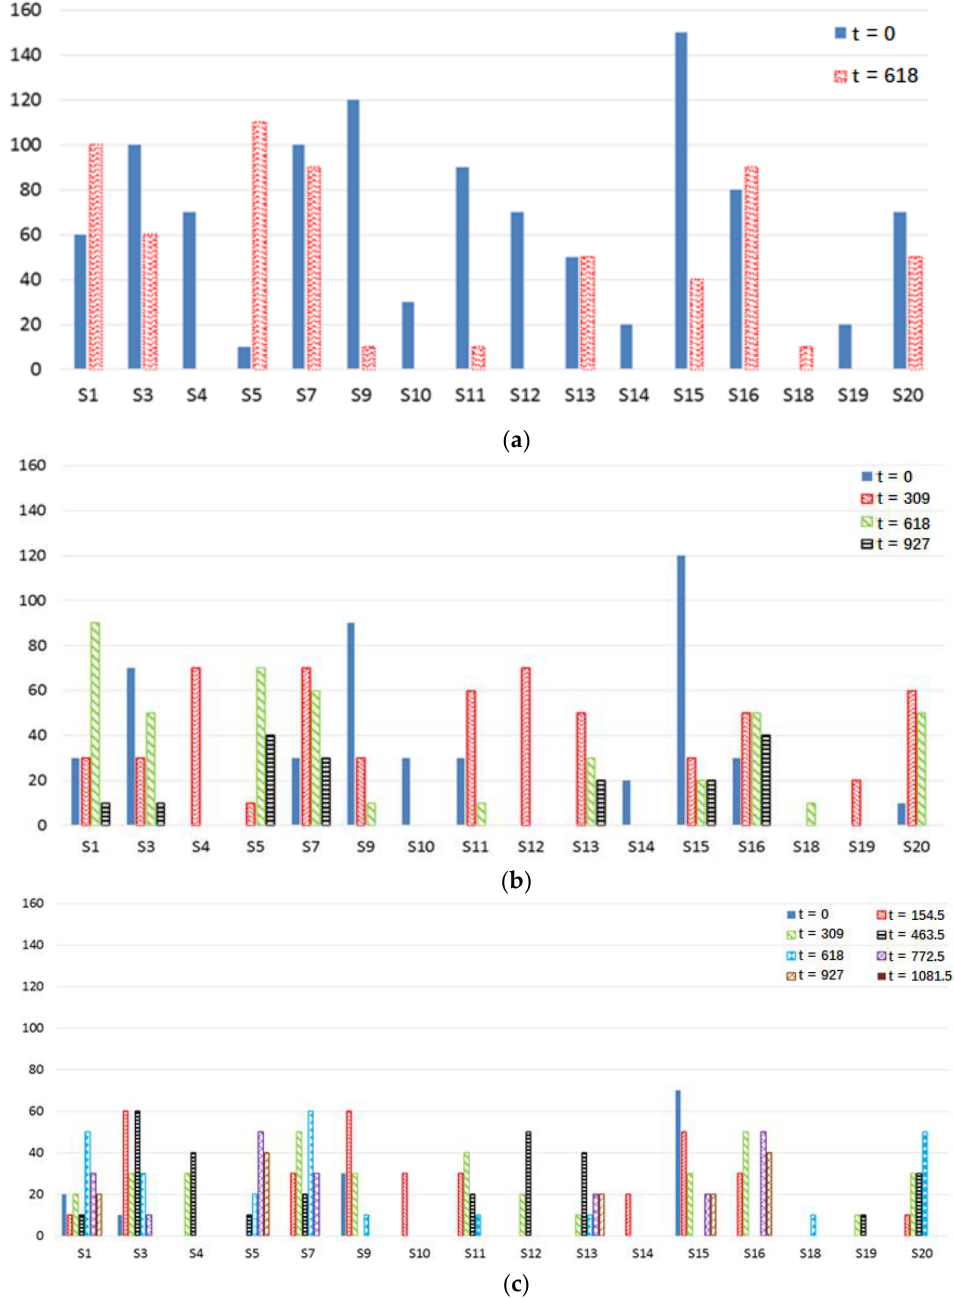
Figure 10. Fluctuation of demand at IDs for instance c101_21 with ( a ) 𝑚 = 2 ; ( b ) 𝑚 = 4 ; and ( c ) 𝑚 = 8 .